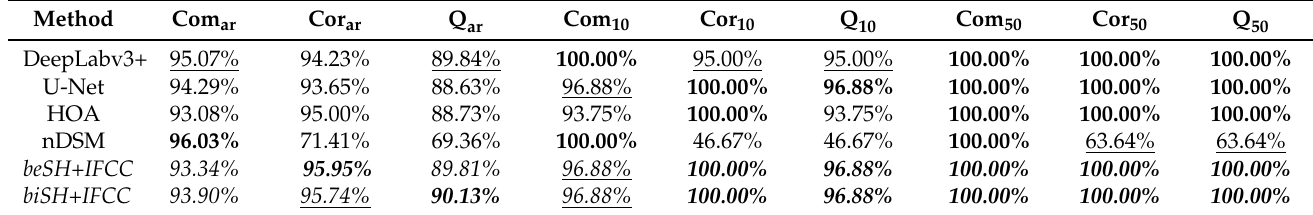
Table 1. Quantitative evaluation results of different methods on the first test area.